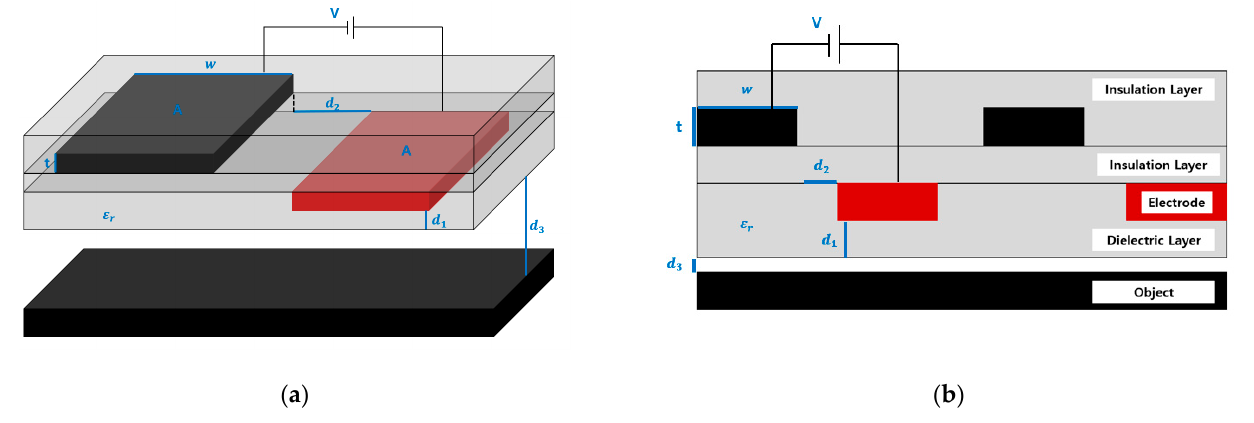
Figure 7. Parameters of the electroadhesion pad: ( a ) perspective view, ( b ) cross section view.